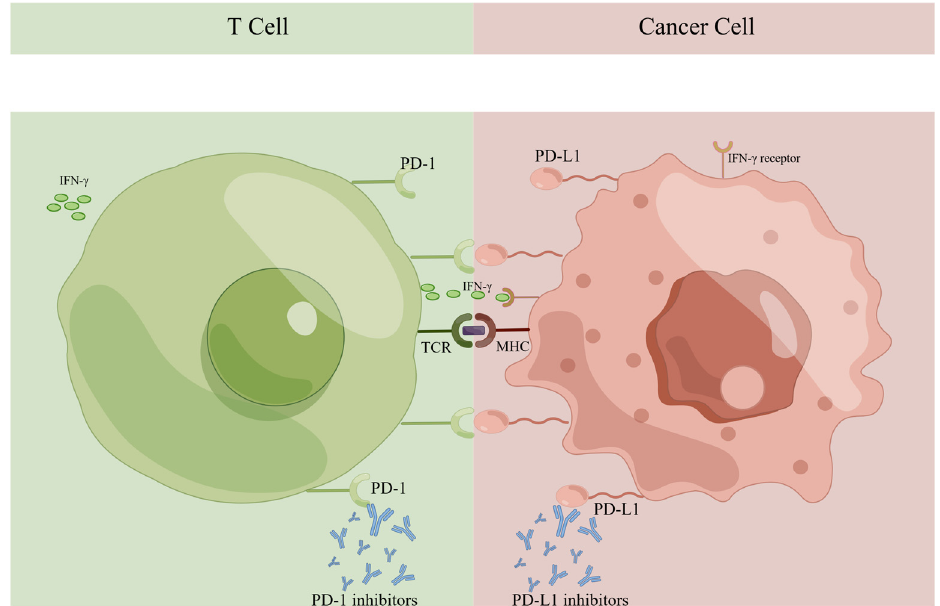
Figure 1. Immune checkpoints PD-1 and PD-L1 in the tumor microenvironment. PD-1, programmed cell death receptor 1; PD-L1, programmed cell death ligand 1; IFN- γ , interferon- γ ; TCR, T-cell receptor; MHC, major histocompatibility complex.